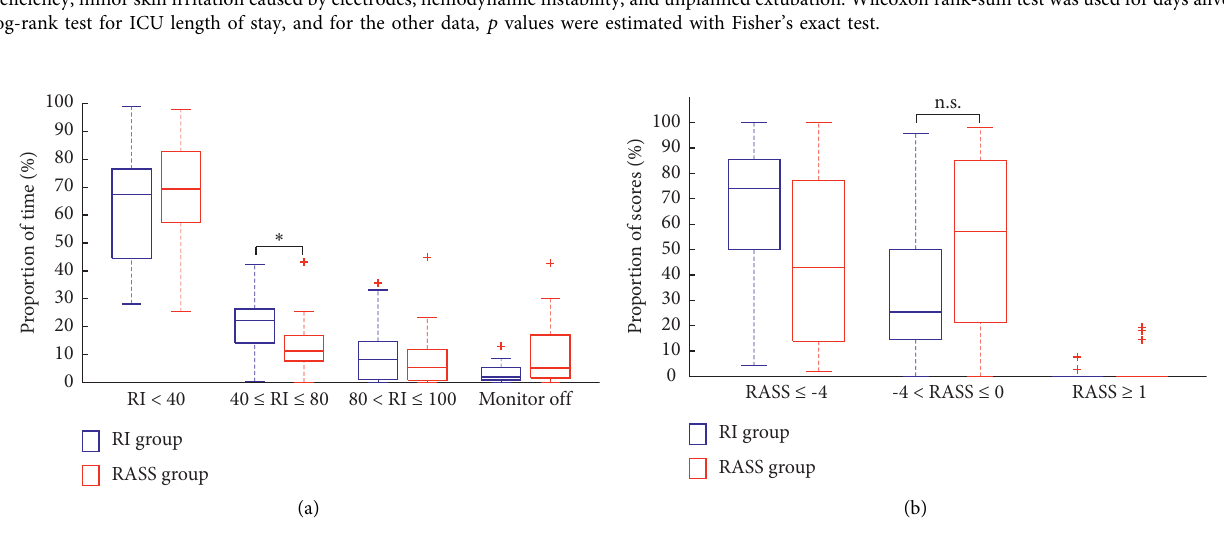
Figure 2: (a) Proportion of monitoring time spent in different RI levels in RI group of patients (blue) and RASS group of patients (red). (b) The proportion of RASS scores. “Monitor off” indicates technical problems, most often sensor contact issues. The horizontal lines within the boxes represent 25%, 50%, and 75% percentiles, the whiskers extend the most extreme data point within 1.5 times the interquartile range, and the crosses represent statistical outliers. ∗ p < 0 . 05; n.s. � no statistical